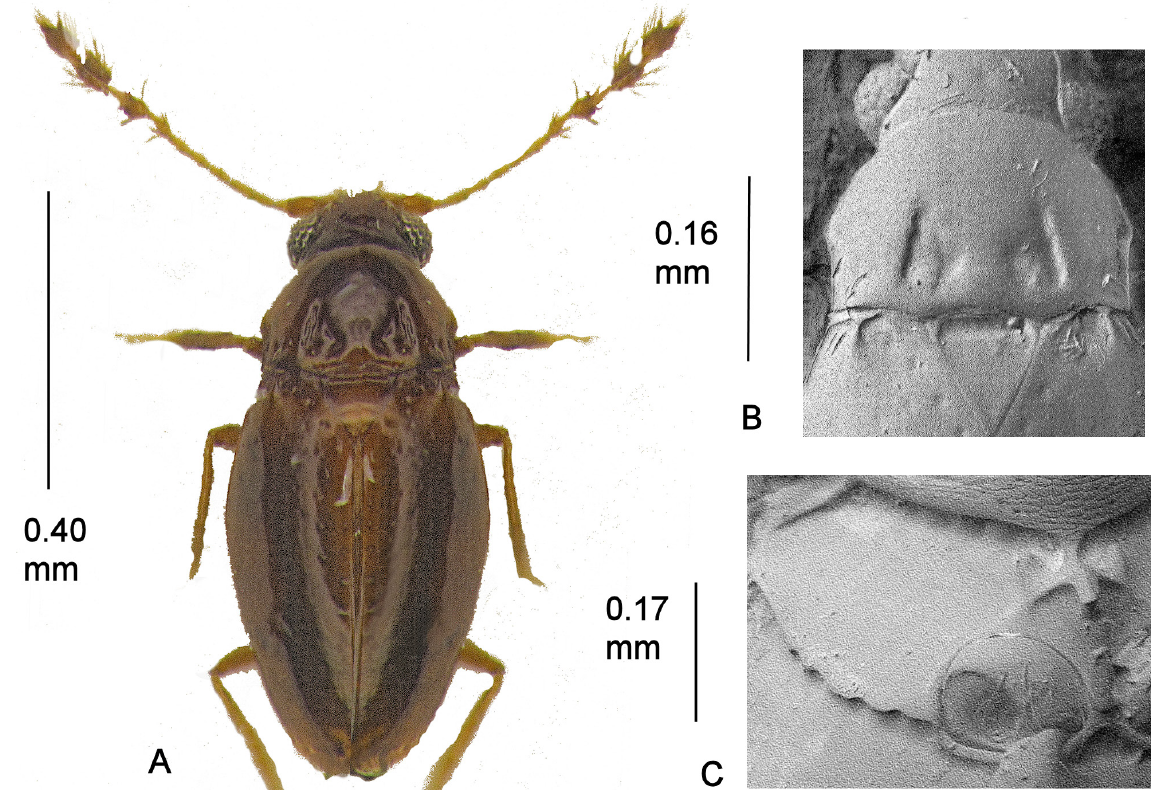
Fig. 16. Cissidium banari Darby, 2013. A . Habitus. B . Pronotum, × 540. C . Mesoventrite showing median process of collar, mid-keel and keel, ×